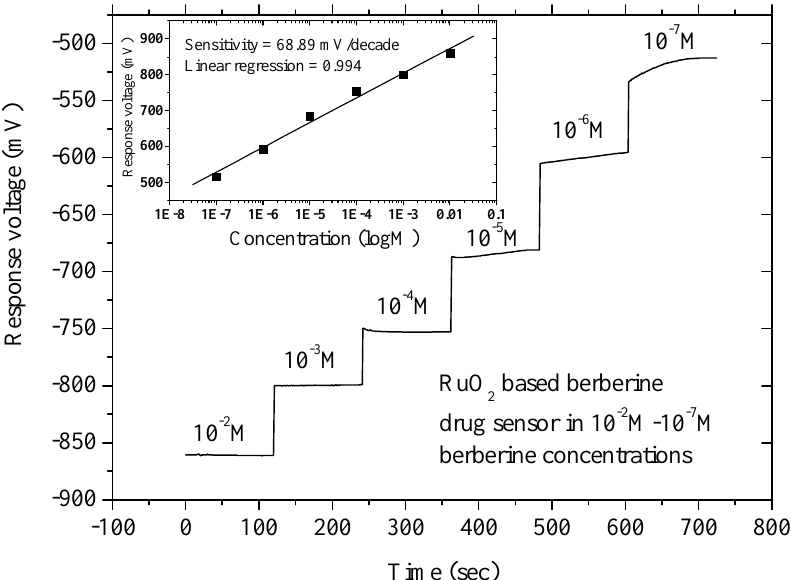
Figure 4. Response voltage versus time characteristics and sensitivity of ruthenium dioxide based berberine drug sensor from 10 -2 M to 10 -7 M concentrations.